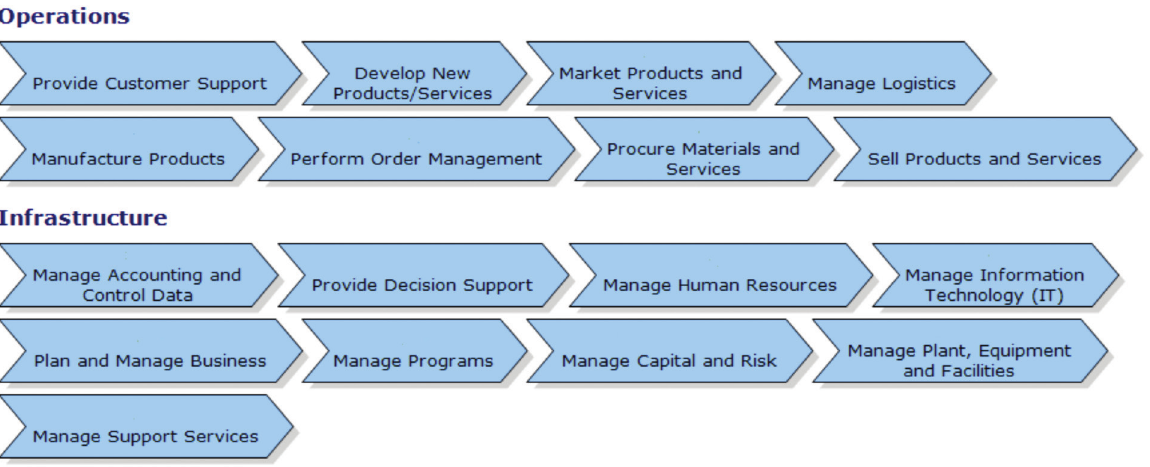
Figure 2: Process map for FMCG supply